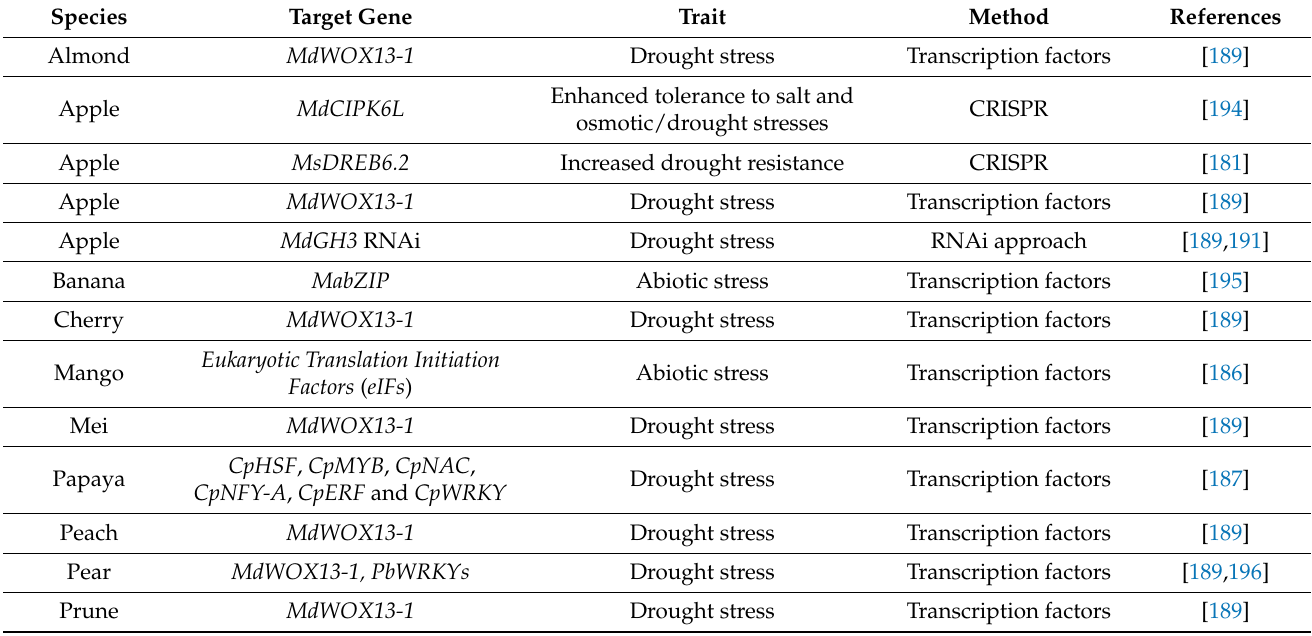
Table 1. Molecular strategies applied to combat drought in fruit